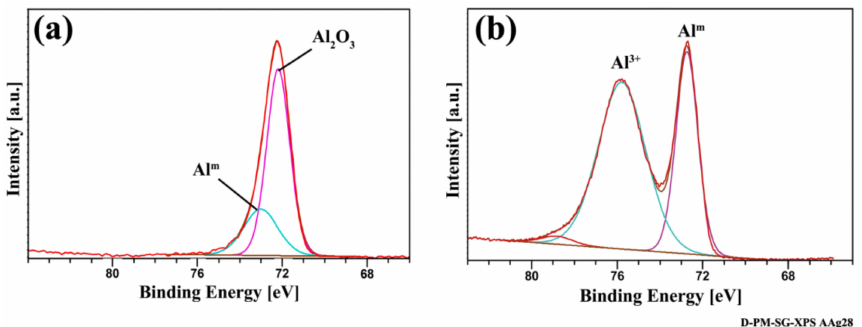
Figure4. High-resolutionAl2pXPSregionspectraoftheSBspecimen( a )beforeagingand( b )afteraging.